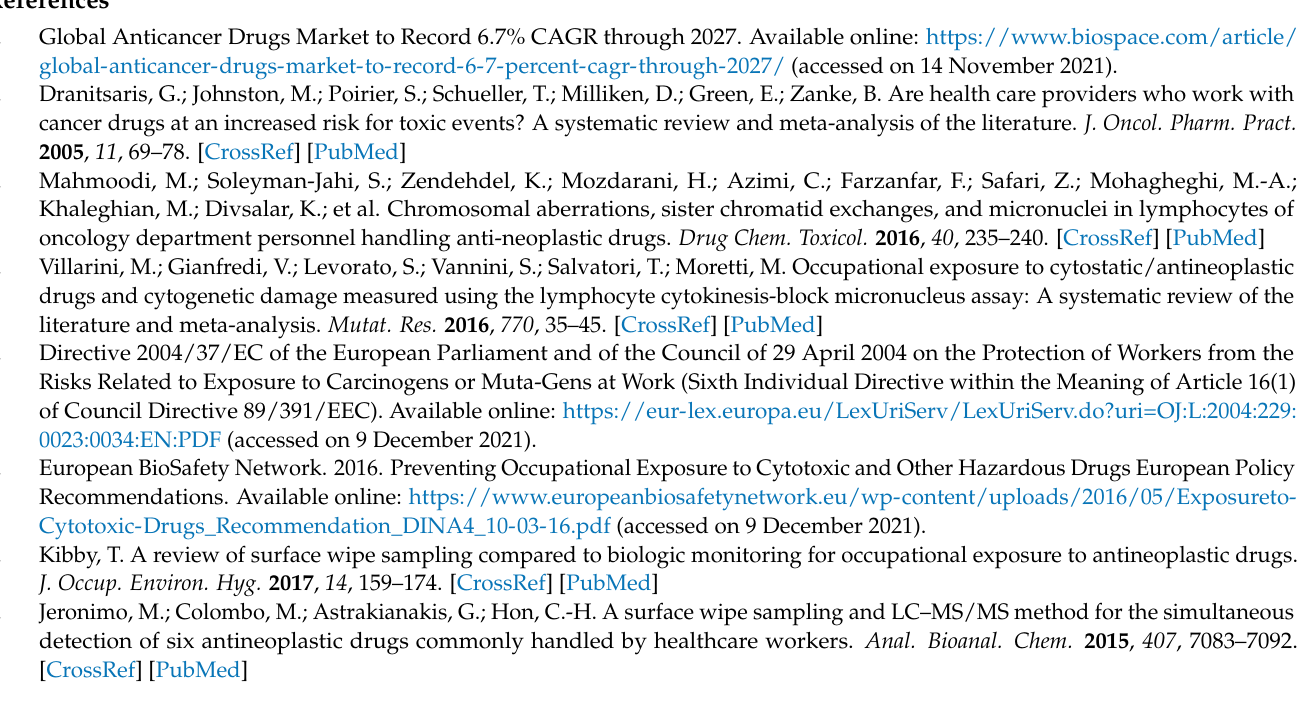
Table S1: Data results for matrix effect (ME). Table S2: Data results of precision and accuracy for the three CQI